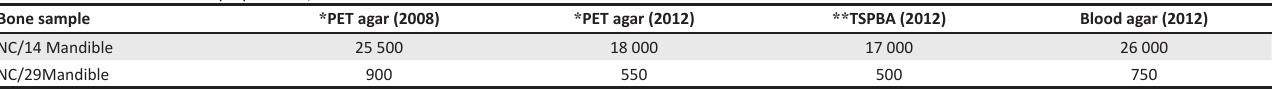
FIGURE 6 (Continues...): Isolation spore counts for bone samples collected from various accessible parts of a carcass, as well as soil sampled from beneath the mouth, abdomen and head of carcasses from farms along the Northern Cape province, Ghaap Plateau during the anthrax outbreaks of 2007–2008. The mean spore counts isolated from each bone type, soil location and farm area are indicated in colony forming units per gram. TABLE 3: Bacillus anthracis spore counts obtained from different isolation media from 1 gram of ground mandibular bones collected during the 2007–2008 anthrax outbreaks in the Northern Cape province, South Africa. Bone sample * PET agar